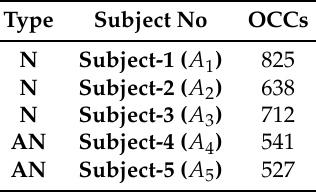
Table 5. Sample ECG and SCG trace of five subjects with observed number of cardiac cycles